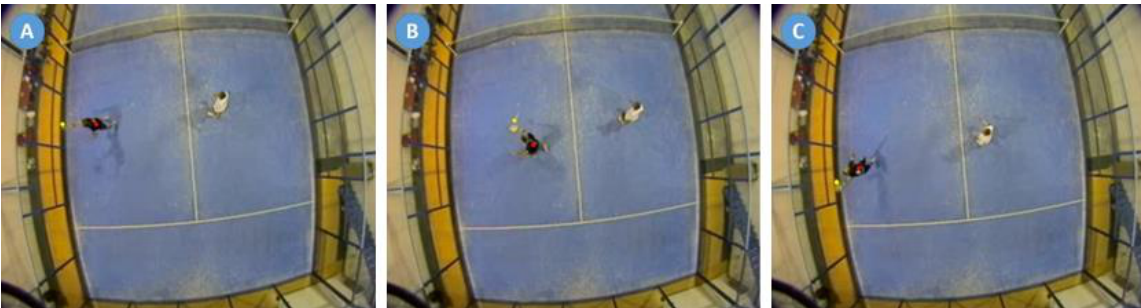
Figure 1. Example of aligned ( A ), forward ( B ), and backward ( C ) ball impact positions.